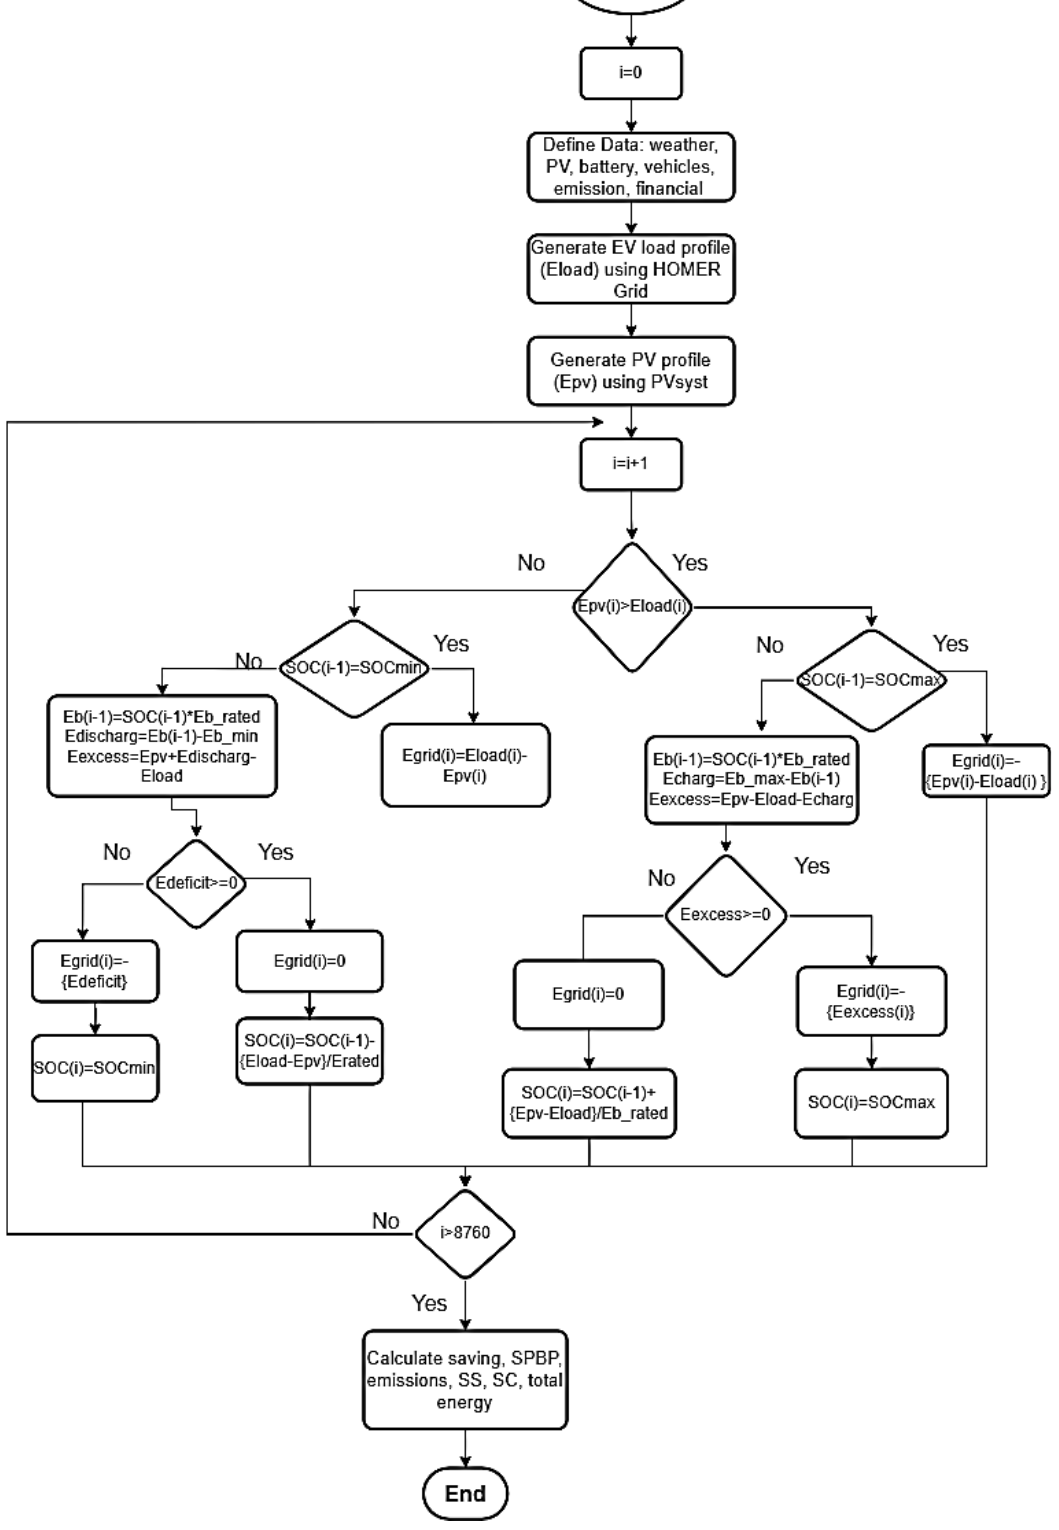
Figure 5. Energy flow model for PV − grid battery charging system .